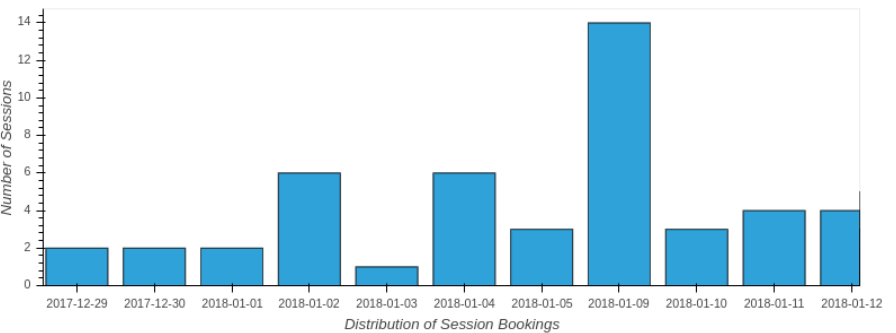
Figure 10. Booking Distribution (from 29th December to 12th January).